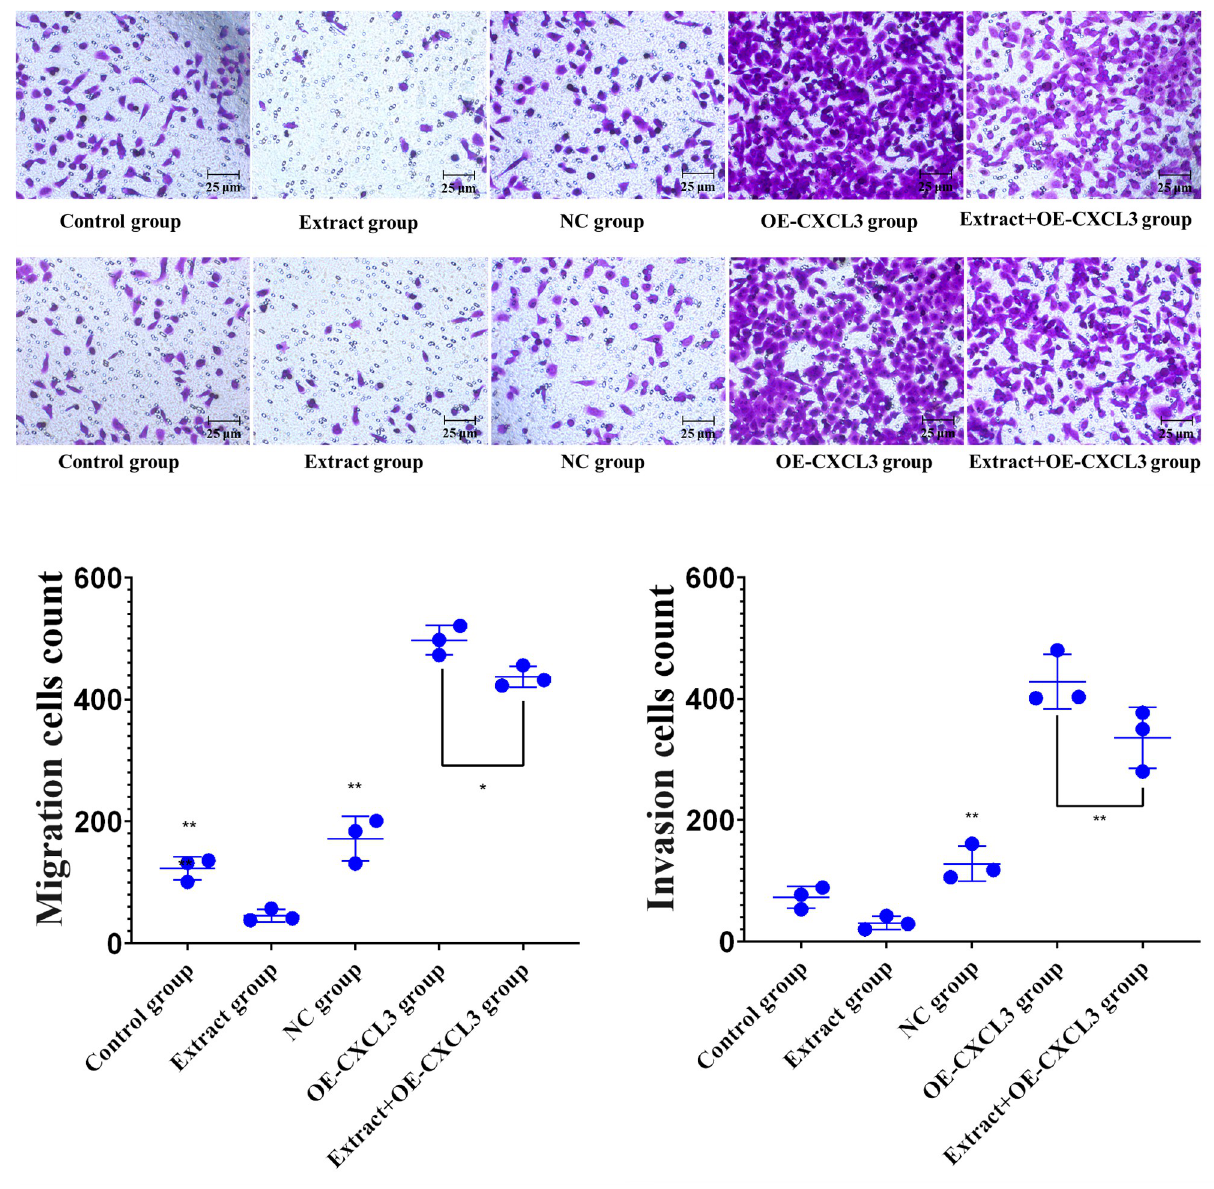
Fig 11. Migration and invasion of HepG2 cells in control, extract, and transfection groups. ( a ) × 200 magnification micrographs of the effects of treatment on HepG2 cell migration. ( b ) × 200 magnification micrographs of the effects of treatment on HepG2 cell invasion. ( c ) Migration cell counts. ( d ) Invasion cell counts. ( � p < 0.05, �� p < 0.01 compared to the extract